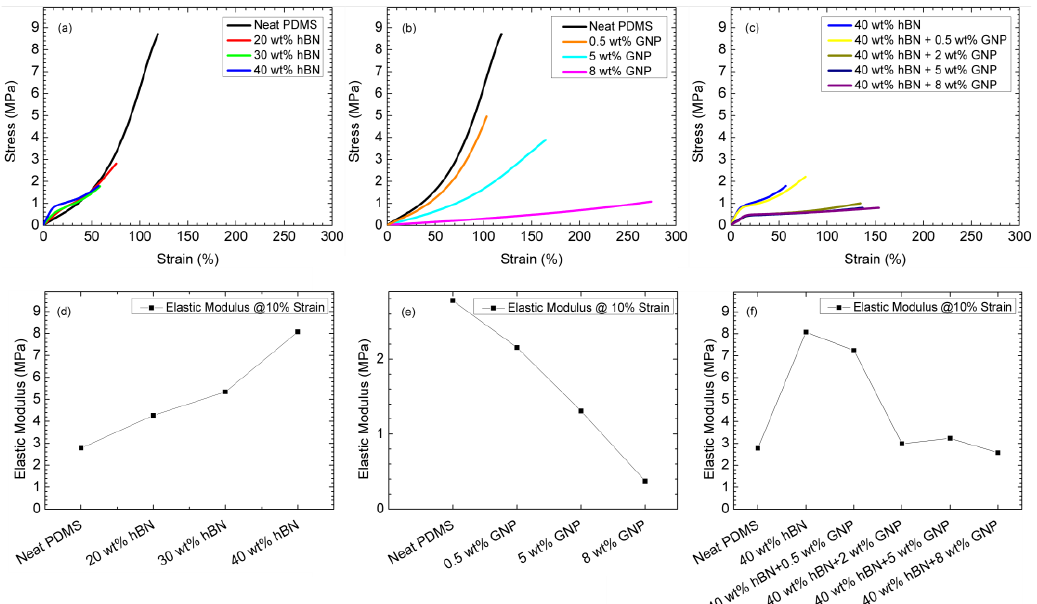
Figure 7. Stress – strain curves of ( a ) hBN/PDMS, ( b ) GNP/PDMS composites and ( c ) hBN/GNP nanocomposites. Plots of the elastic modulus at 10% strain of PDMS-based nanocomposites containing ( d ) hBN, ( e ) GNPs, ( f ) hBN and GNPs.